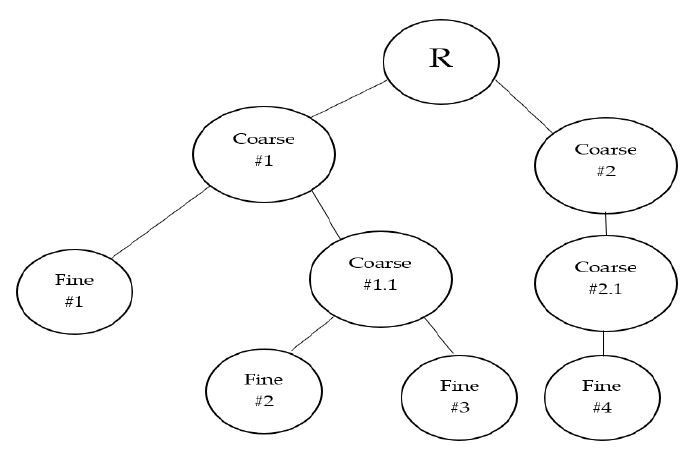
Figure 4. An example of the hierarchical tree structure.